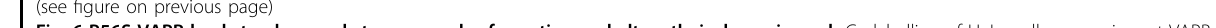
Fig. 6 P56S-VAPB leads to abnormal stress granules formation and alters their dynamics. a , b Co-labelling of HeLa cells expressing wt-VAPB and P56S-VAPB with antibodies against SG markers TIAR1 ( a ) and G3BP ( b ), showing cytoplasmic SG formation (arrowheads) in P56S-VAPB expressing cells. Scale bar: 10 µm. c Immuno fl uorescence analysis of HeLa cells stably expressing SG protein G3BP, showing SG formation in P56S-VAPB transfected cells compared to wt-VAPB transfected cells after 24 h. Scale bar: 10 µm. d Quanti fi cation of TIAR1 in HeLa cells and G3BP stable cell lines for SGs formation due to overexpression of either the wt-VAPB or P56S-VAPB after 36 h of transfection. e , f FRAP analysis by live cell imaging on the above cell lines showing reduced recovery of G3BP-SGs in P56S-VAPB transfected cells compared to wt-VAPB transfected cells, Quanti fi cations ( f ). Scale bar: 10 µm. g Immunoblot analysis subcellular fractions of HeLa cells expressing wt-VAPB and P56S-VAPB, showing increased levels of TIAR1 in cytoplasmic fraction (red arrowhead, CE) in P56S-VAPB expressing cells. h , i DAB immunohistochemistry using antibodies against SG marker TIAR1 in lumbar spinal cord α -MNs of wt and P56S-VAPB Tg mice ( h ) and in ALS8 muscle biopsy ( i ), showing altered nuclear immunoreactivity (arrows) and diffuse albeit increased cytoplasmic immunoreactivity (arrows) in both α -MNs of P56S- VAPB tg mice as well as in ALS8 muscle biopsy. (Scale bars: 15 µm in h , 60 µm in i . j Accumulated globular immunoreactive TIAR1 aggregates co-localises with VAPB aggregates (arrowheads) in ALS8 muscle biopsy. Scale bars: 25